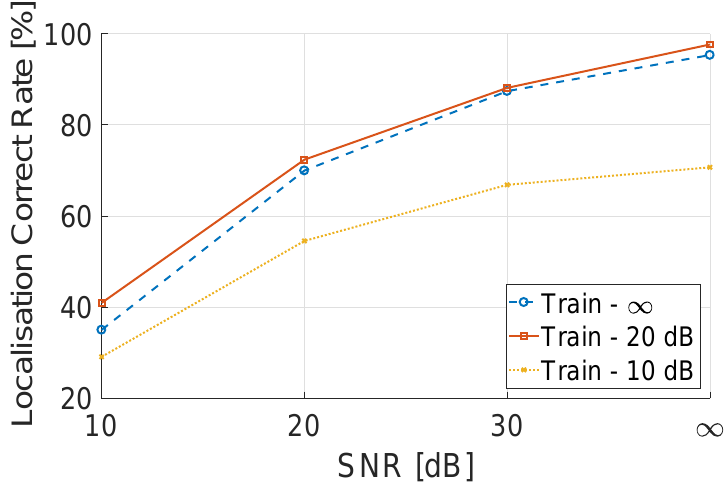
Figure 7. Comparing the localization accuracy with different training conditions. The angular error tolerance is 2.5 ◦